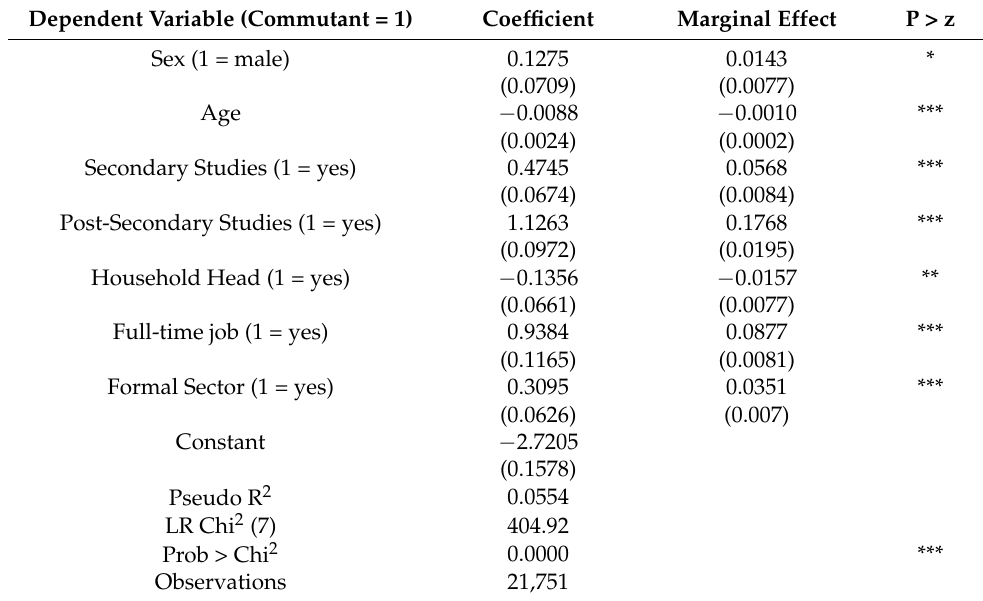
Table 3. Logistic estimation result and marginal effects: Chile.